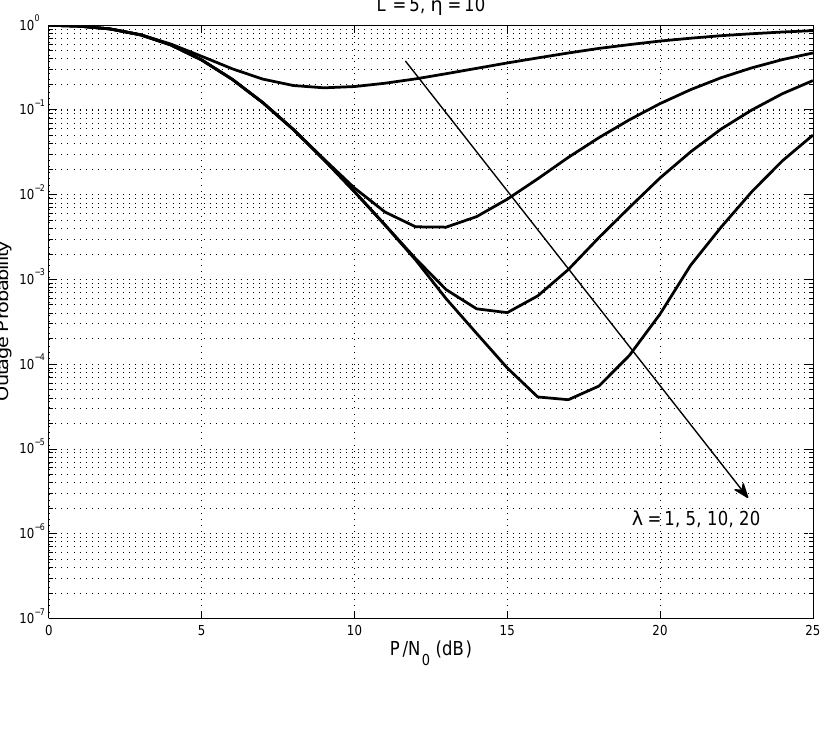
Figure 4. Outage probability of the system with L = 5 for interference constraint λ = 1, 5, 10, 20 and outage threshold η = 10.